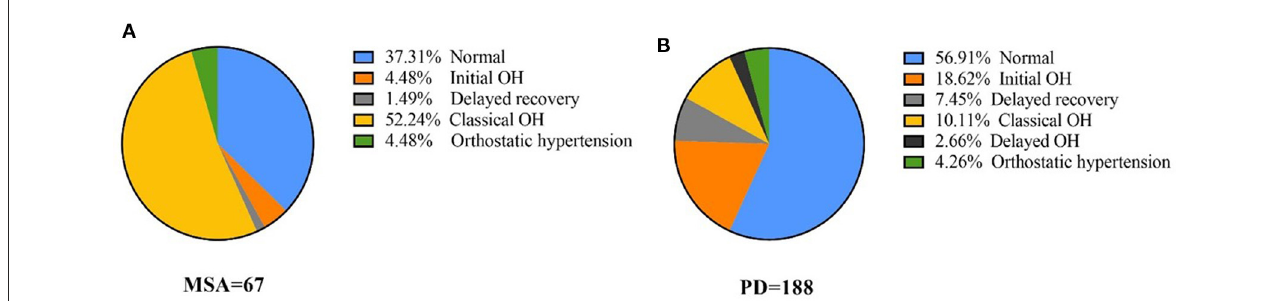
FIGURE1 The proportion of orthostatic hypotension and all its variants in MSA and PD (A) proportion of blood pressure of different OH types in MSA, (B) proportion of blood pressure of different OH types in PD.